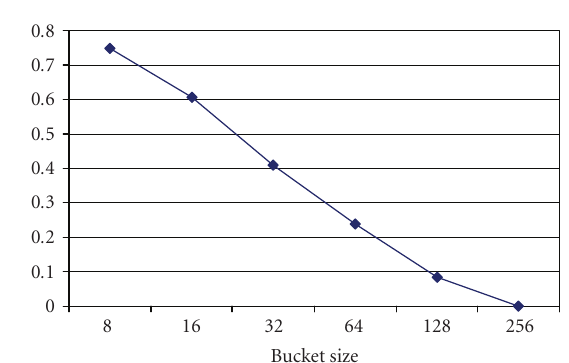
Figure 11: CAM size required to accommodate rules moved to CAM as percentage to the total number of rules.